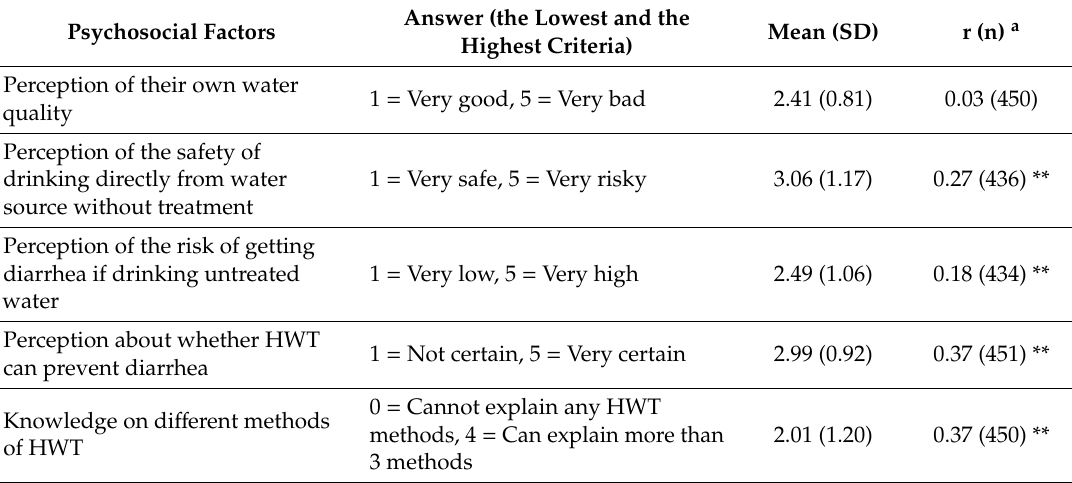
Table 2. Bivariate associations between psychosocial factors and the use of